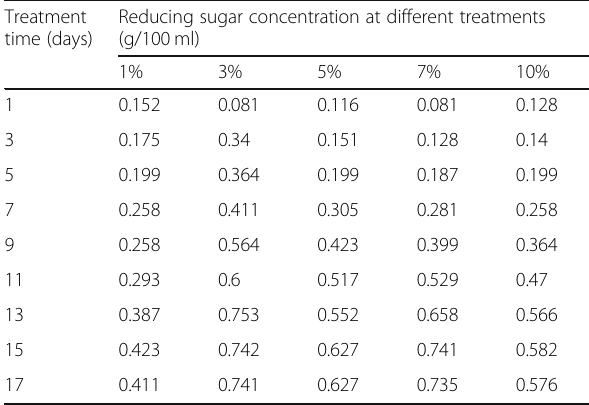
Table 5 Reducing sugar obtained after bacterial hydrolysis for treated rice straw Treatment time (days)